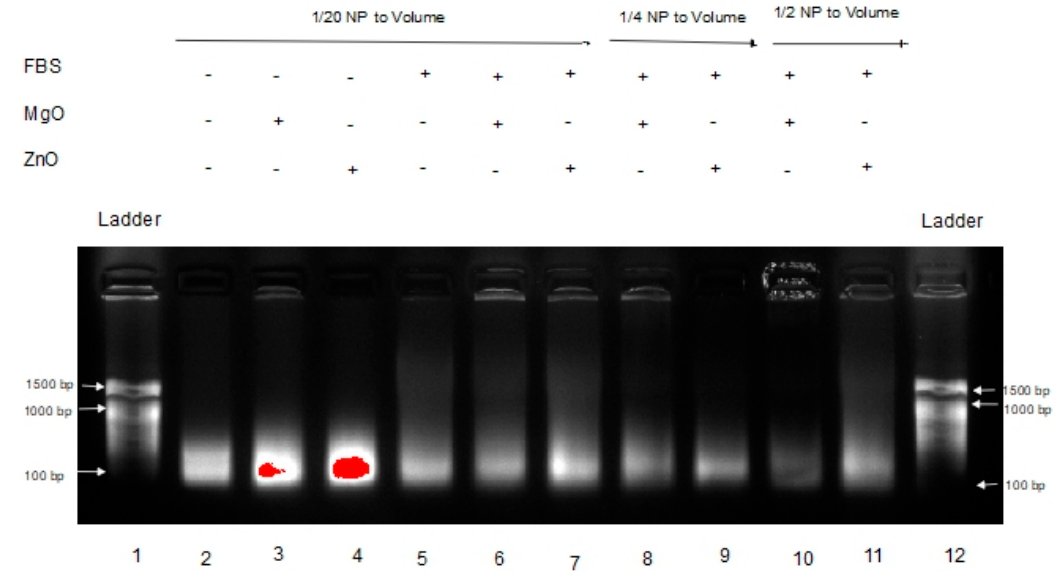
Figure 3. Effects of MgO and ZnO at various concentrations in Fetal Bovine Serum (FBS).